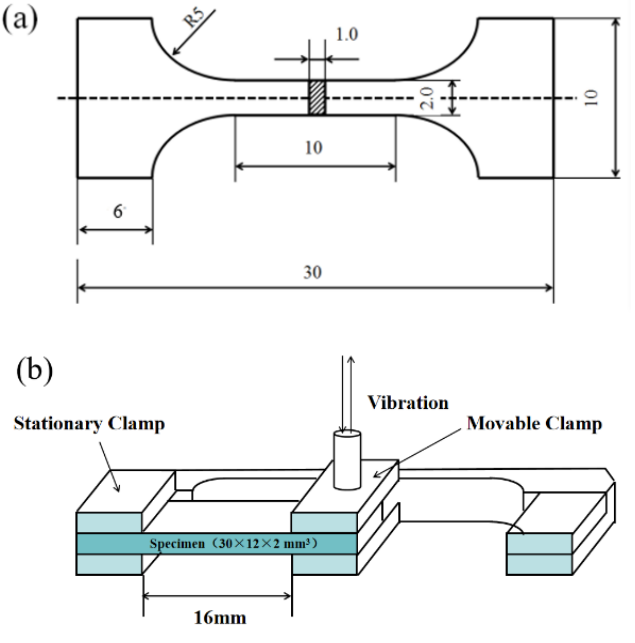
Figure 2. ( a ) The shape and size of tensile specimens; ( b ) schematic diagram of the single cantilever clamp.